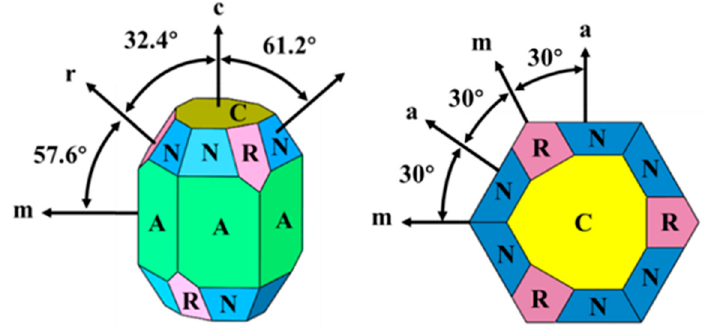
Figure 1. Crystal structure of the single-crystal